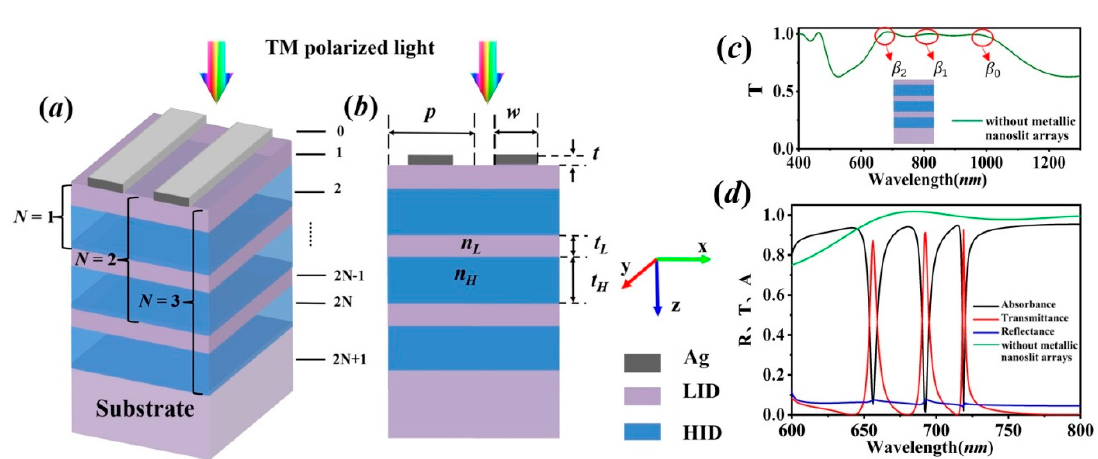
Figure 1. ( a ) 3D view; ( b ) cross-section view of configuration of the ultra-thin metallic nanoslit arrays on N-layer stacked LID–HID above the LID substrate (N is the layers of LID–HID, here take N = 3 as an example); ( c ) the transmission spectrum of 3-layer (N = 3) stacked LID–HID structures without metallic nanoslit arrays; ( d ) the spectra of the ultra-thin metallic nanoslit arrays on 3-layer (N =